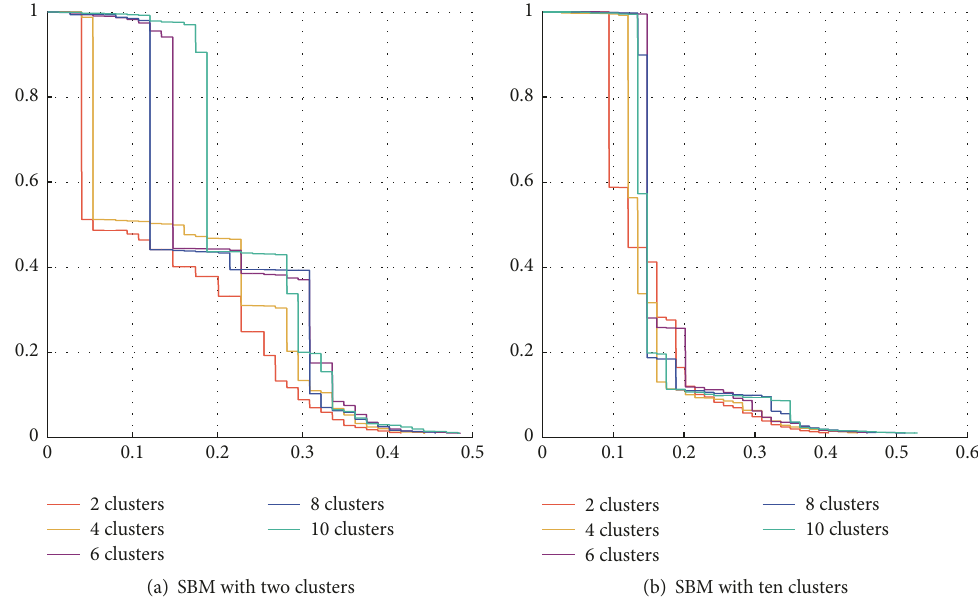
Figure 7: The size of the GCC of the networks versus link removing proportion, comparing of different quantities of target disconnected clusters in HPI-Ncut